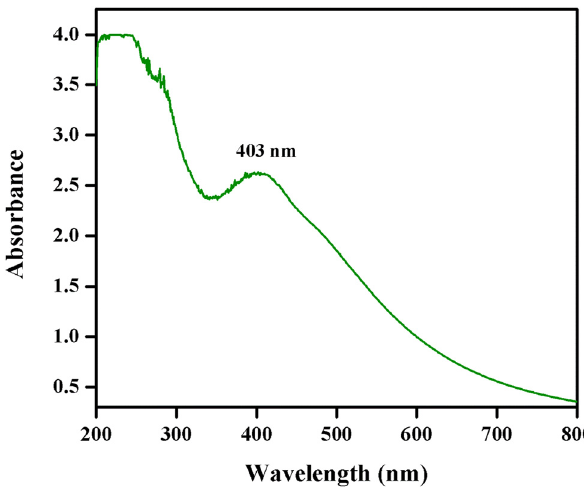
Figure 1: UV - Vis spectrum of synthesized agar - mediated silver nanoparticles ( Ar - AgNPs ) .